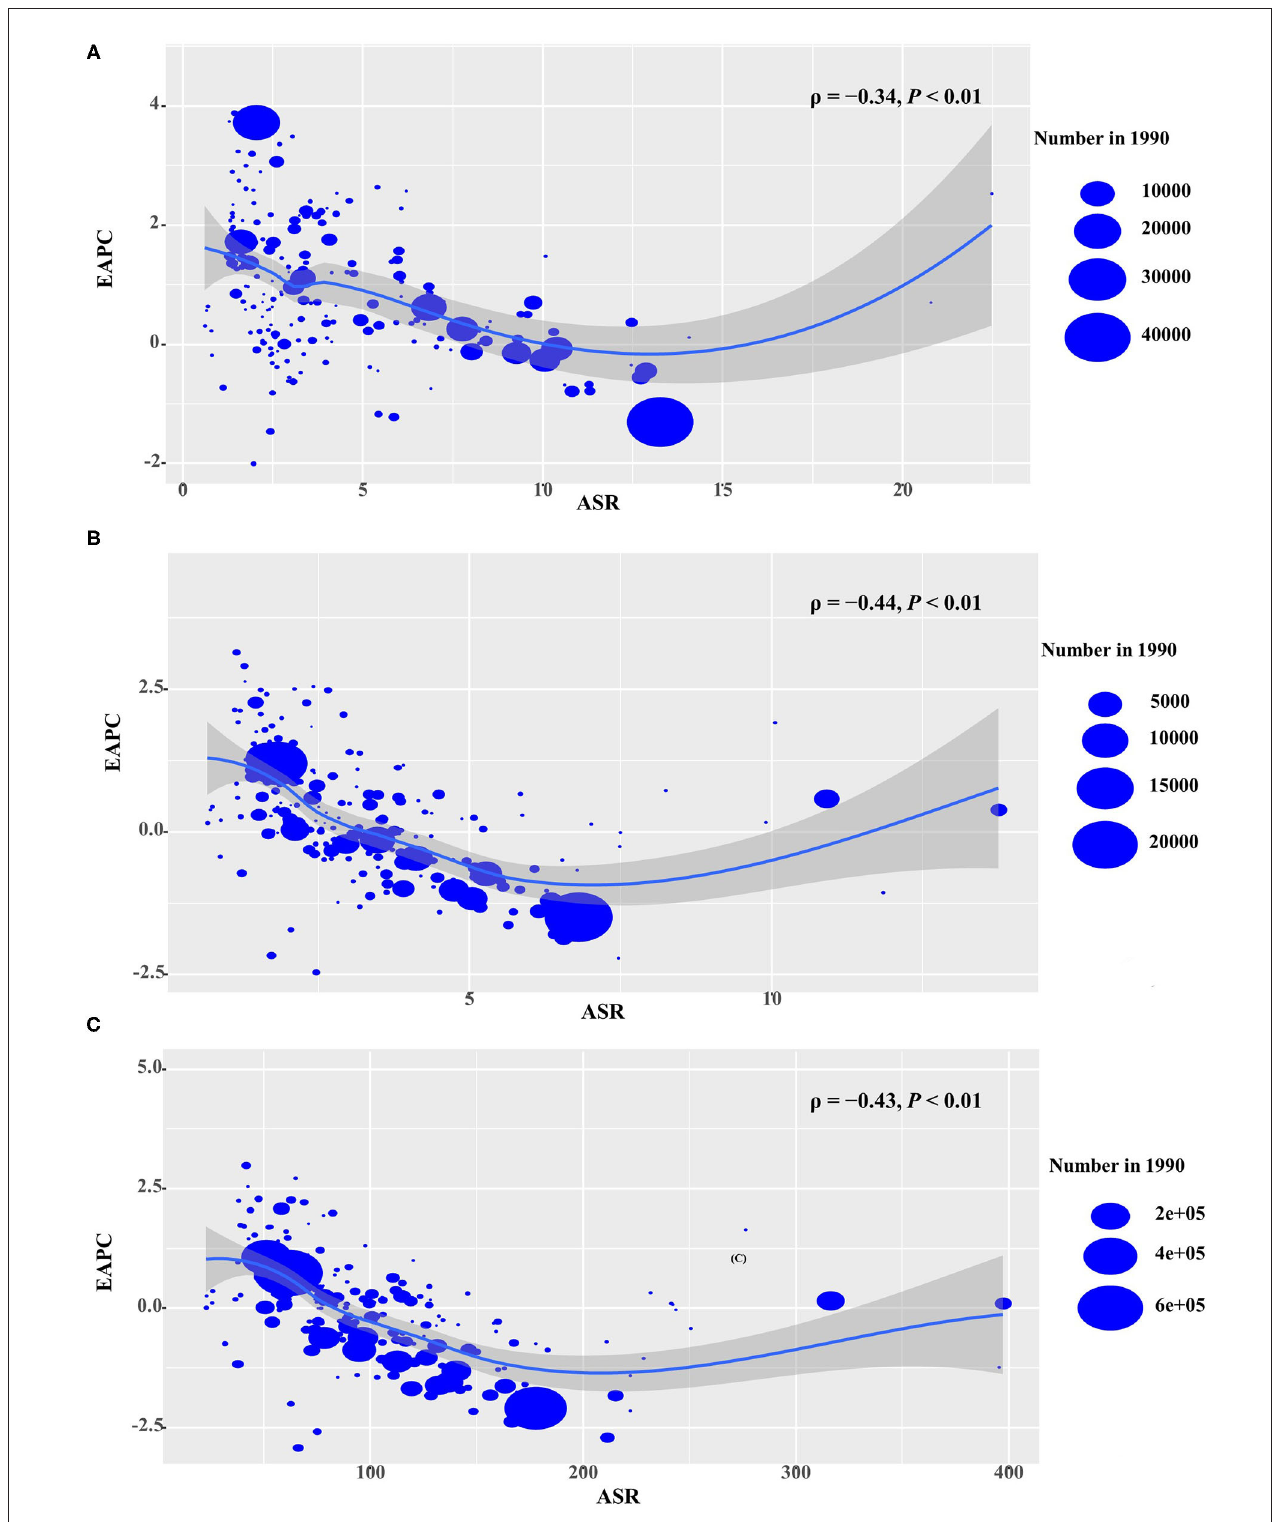
FIGURE 4 | Correlation between EAPCs and ASR in 1990 at the national level. (A) EAPCs of incidence, (B) death, and (C) DALYs had negative associations with ASR in 1990. The association was calculated by a Pearson correlation analysis. The size of the circle is increased with the numbers in 1990. EAPC, estimated annual percentage change; ASR, age-standardized rate. DALYs, disability-adjusted life years.